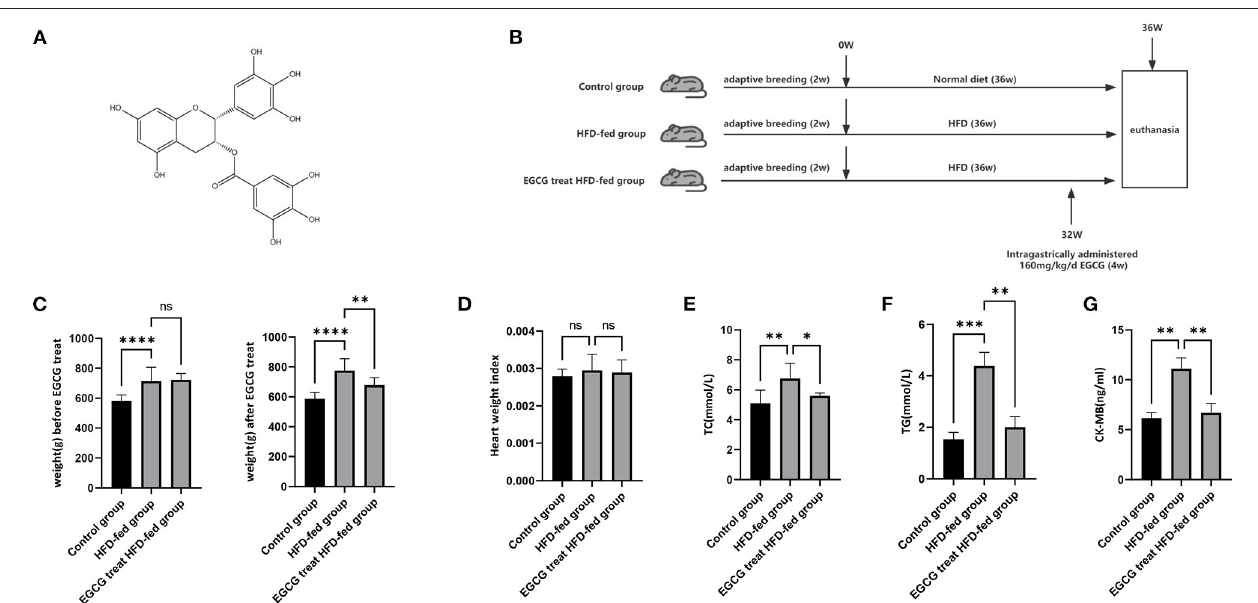
FIGURE 1 | EGCG could relieve the burden of lipid metabolism and myocardium injury. (A) Chemical structure of EGCG; (B) Schematic diagram of the experimental setup of HFD-fed and EGCG treatment; (C) The effect of HFD and EGCG treatment on weight; (D) The effect of HFD and EGCG treatment on heart weight index. The heart weight index was calculated as HWI = heart weight (HW)/body weight (BW); (E) The effect of HFD and EGCG treatment on serum TC levels was quantified; (F) The effect of HFD and EGCG treatment on serum TG levels was quantified; (G) The effect of HFD and EGCG treatment on serum CK-MB levels was quantified. (* p < 0.05, ** p < 0.01, *** p <